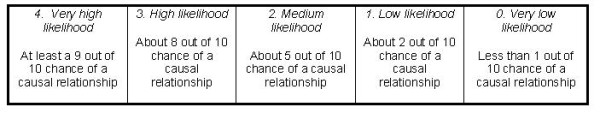
Level of confidence scheme used for likelihood rating, adapted from [27].